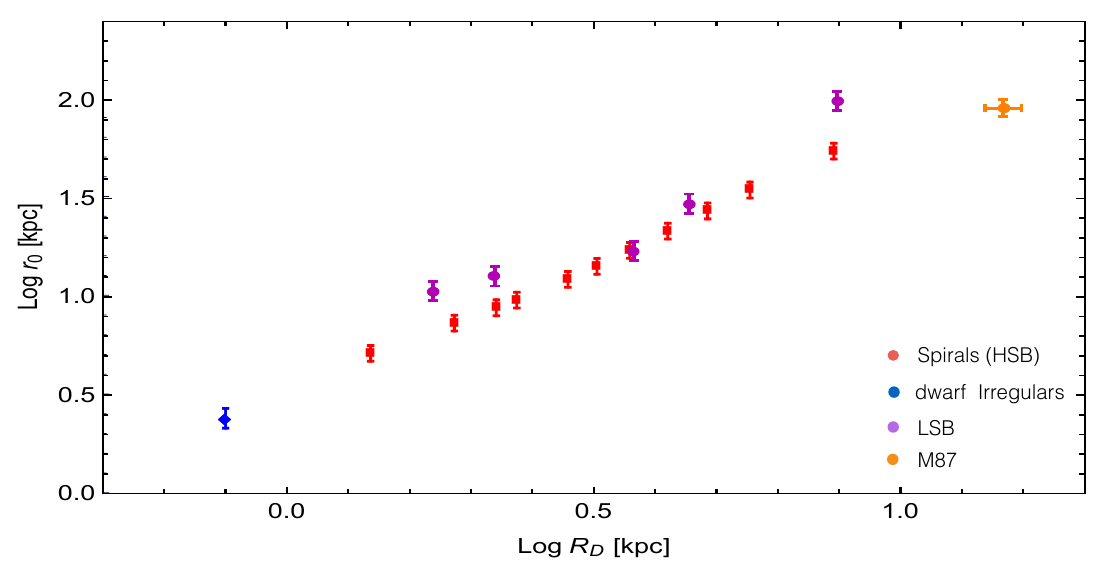
Figure 1. Log r 0 vs log R D in normal Spirals ( red ), dwarf Spirals ( blue ), Low Surface Brightness ( magenta ) and the giant elliptical M87 ( orange Figure 1 . The r 0 vs R D correlation in normal (red) and dwarf spirals (blue). log r 0 shown)